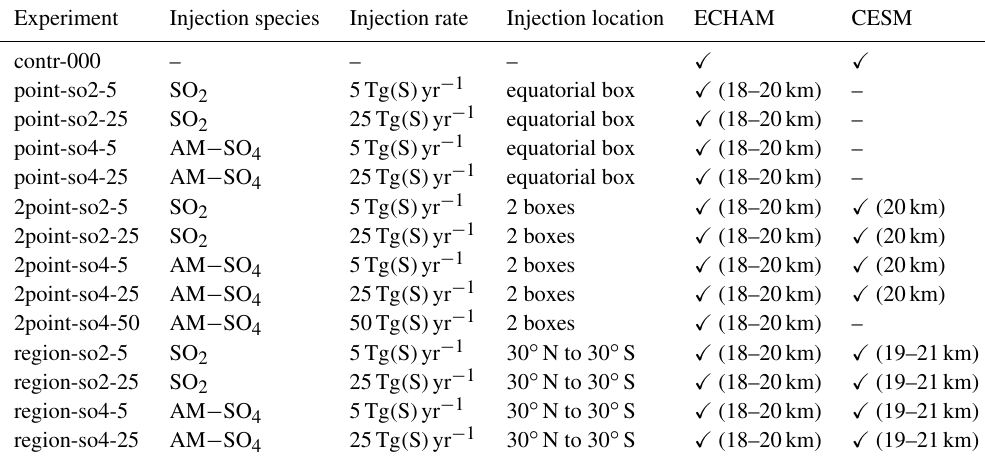
Table 1. Setup of all performed simulations. The point injections have been performed in a single equatorial grid box centered at 1.4 ◦ N, 180 ◦ E; the 2point injections have been performed in two boxes centered at 29.3 ◦ N, 180 ◦ E and 29.3 ◦ S, 180 ◦ E; and the region injections have been performed in a belt along the whole Equator, ranging from 30 ◦ N to 30 ◦ S. The injection rate is the total amount of sulfur that is injected globally per year. Check marks indicate whether the experiment was performed for the according model, while values in parenthesis after the check marks indicate the injection